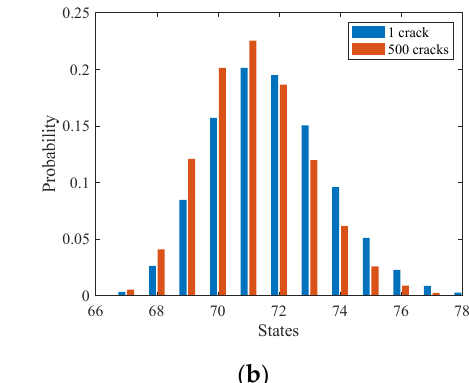
Figure 16. Posterior probability distribution of the EICS inferred from the field inspection results.